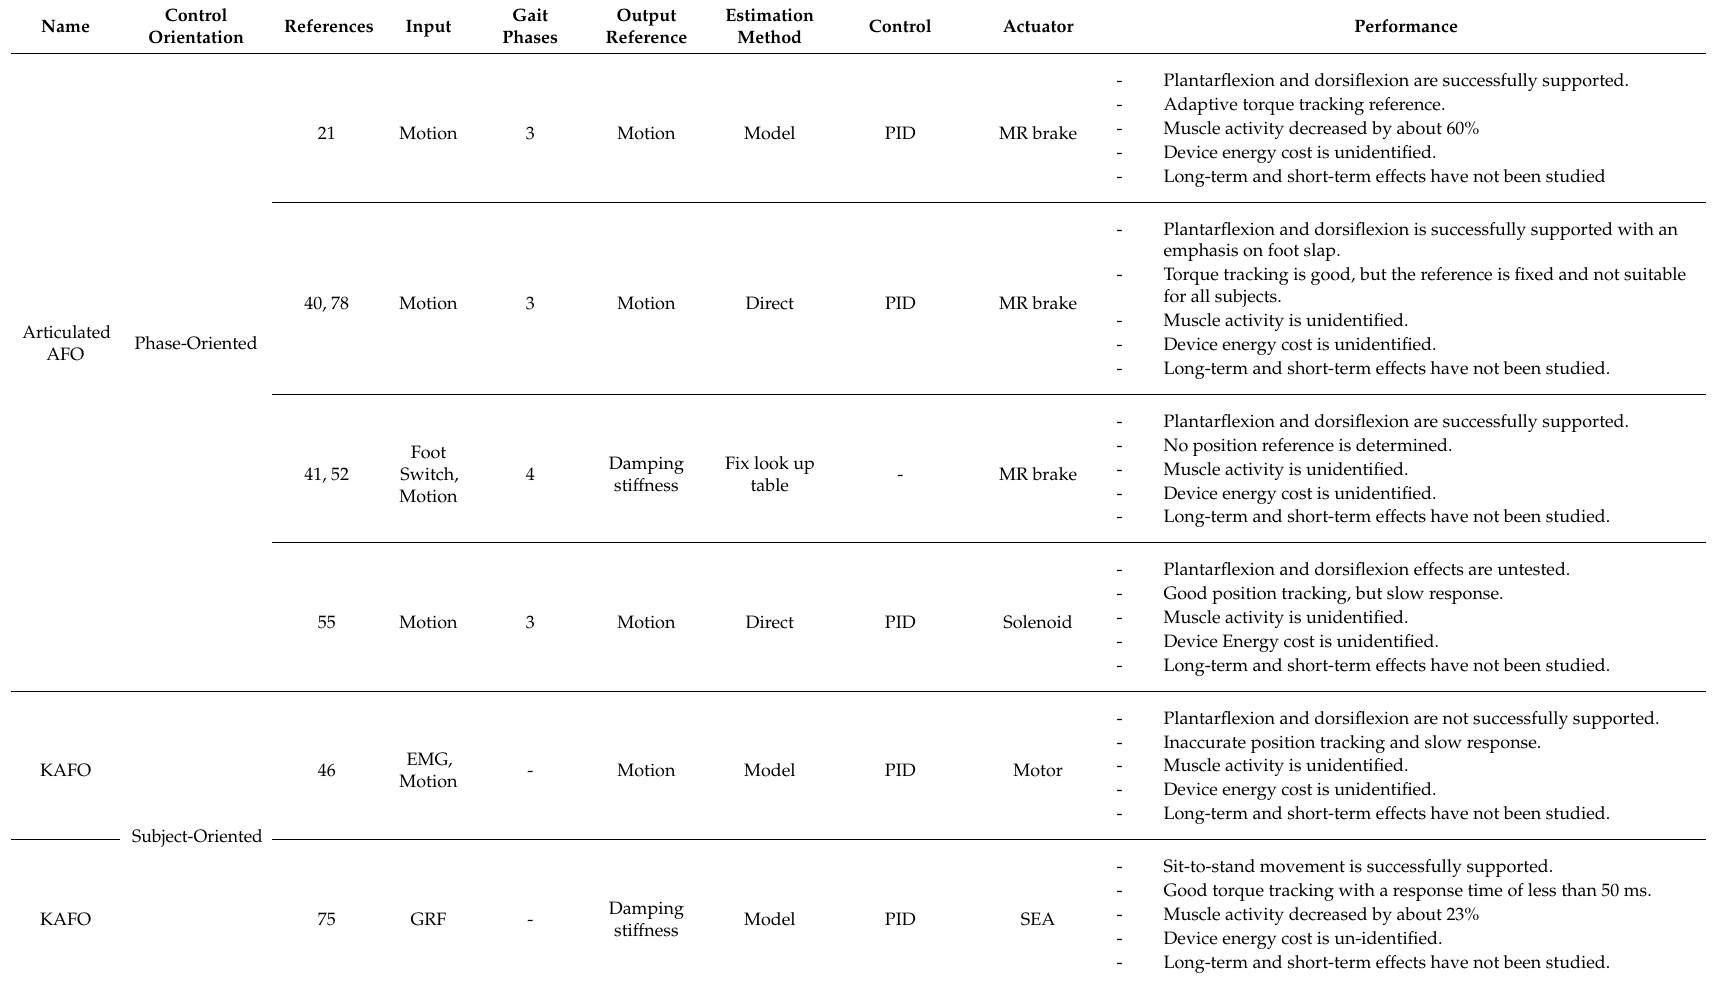
Plantarflexion and dorsiflexion are successfully supported. - Adaptive torque tracking reference. - Muscle activity decreased by about 60% - Device energy cost is unidentified. -